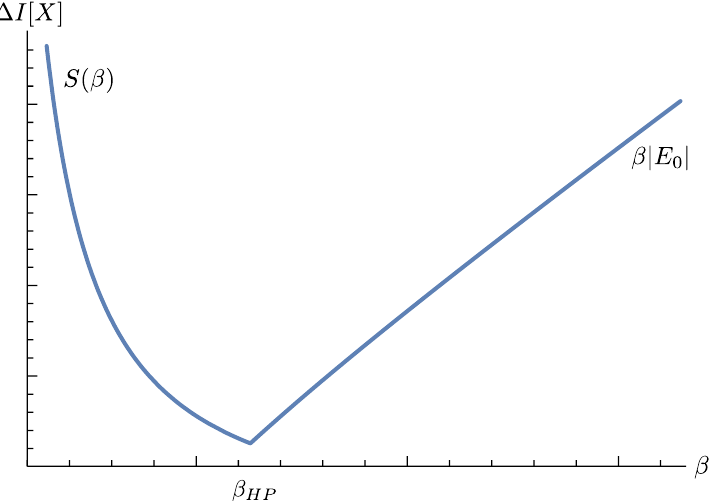
Figure 5 . Renormalized action of the wormhole ∆ I [ X ] as a function of the temperature, for d = 2 . The Hawking-Page transition at β HP = 2 π affects the normalization of the